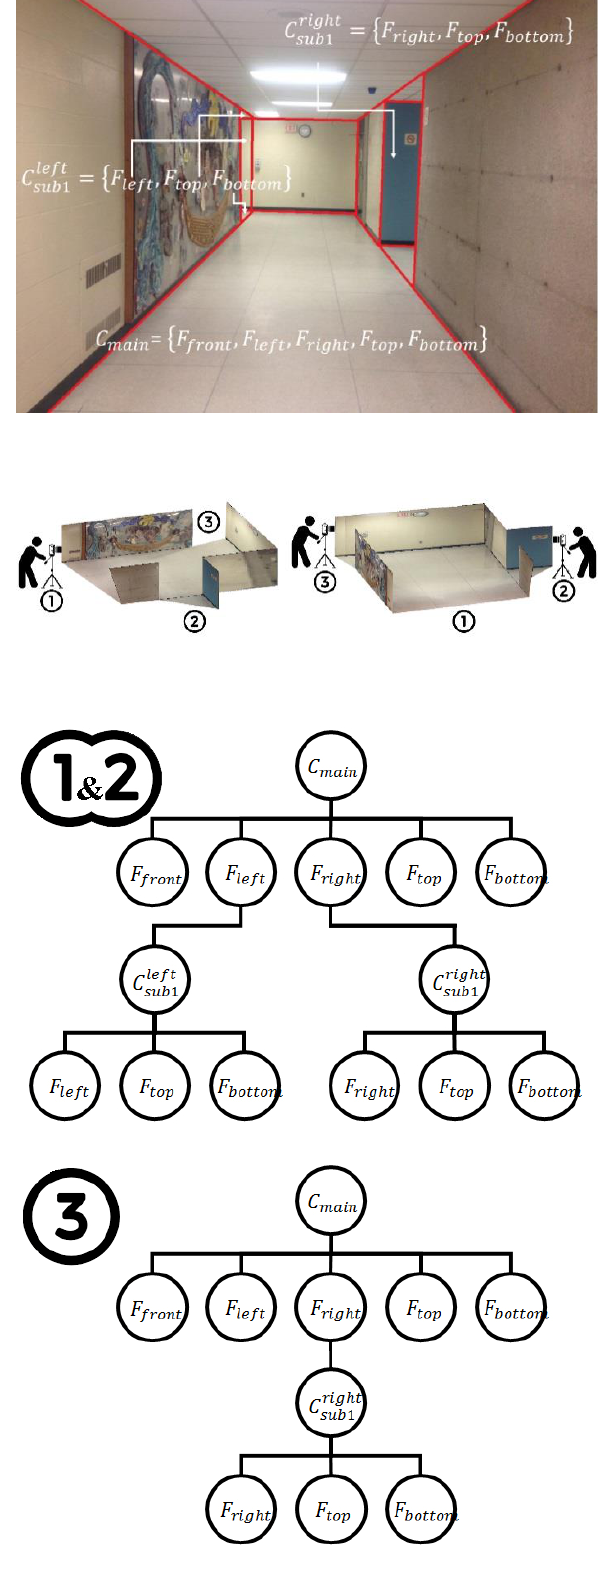
Figure 4. Top: A single image with specified corridor layout; Middle: Reconstructed 3D model; Camera is hypothesized to stand at various positions (1, 2 and 3); Bottom: The generated corridor topological